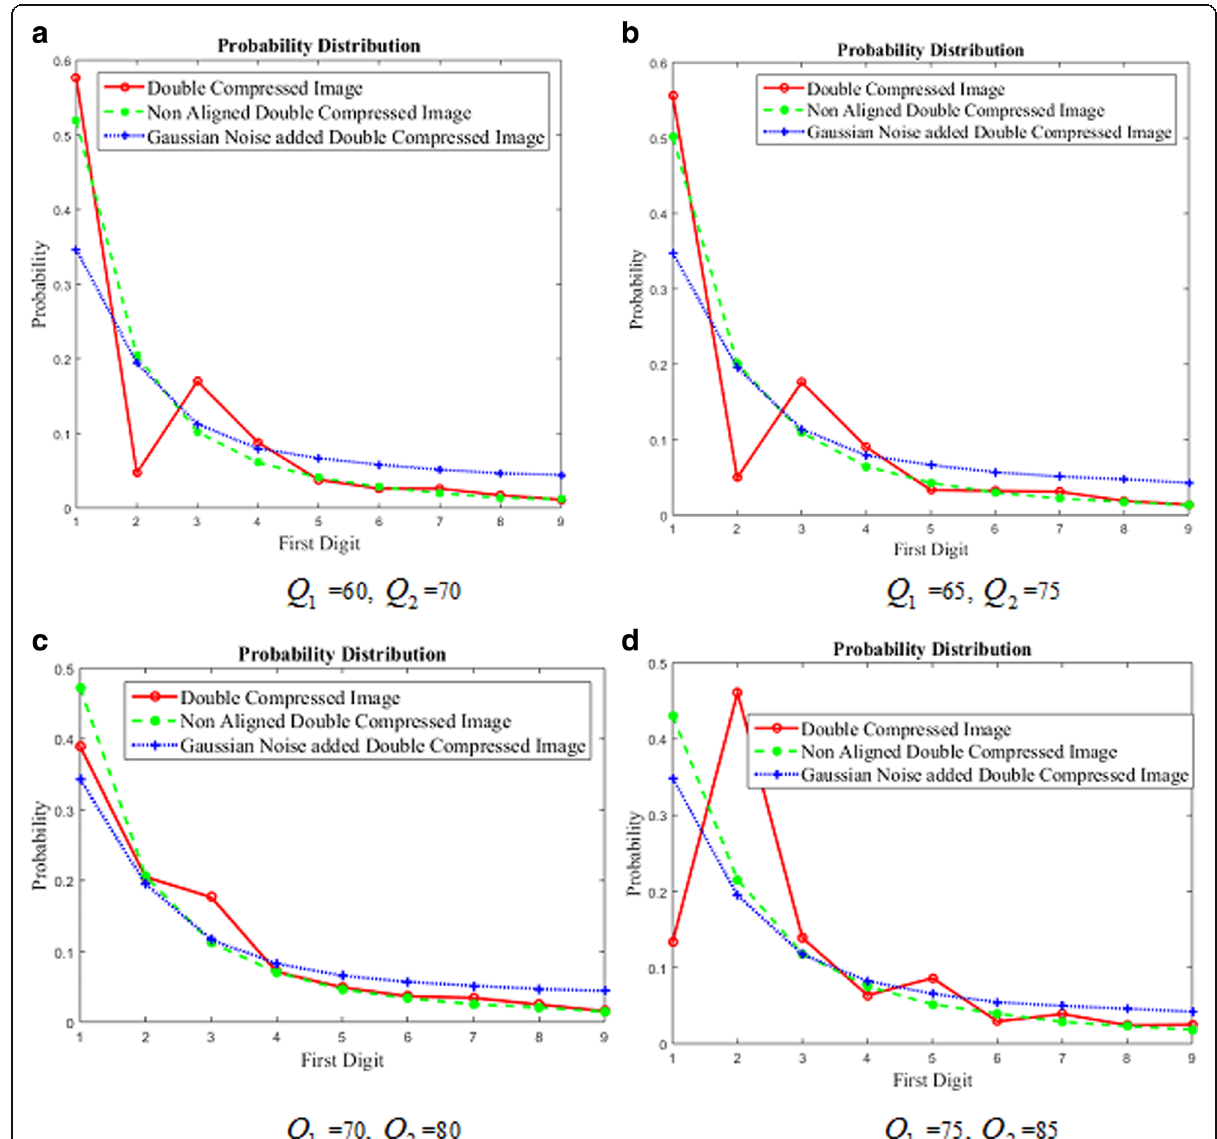
Fig. 2 a – d Probability distribution of ADJPEG compressed image, NADJPEG compressed image, and Gaussian noise-added ADJPEG compressed image at various primary and secondary compression qualities Q 1 and Q 2 ,